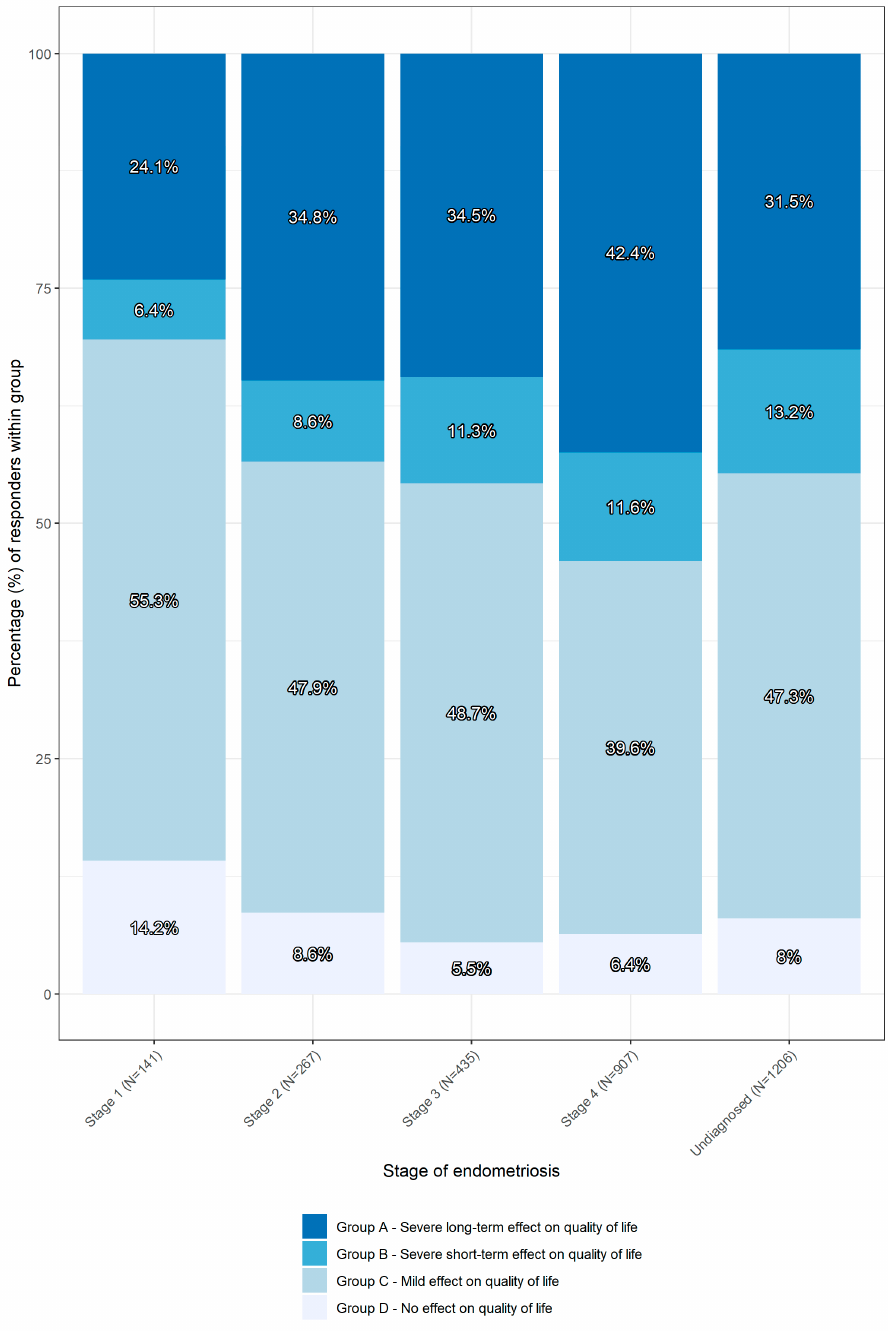
Figure 1. Reported everyday experiences of quality of life in relation to the stage. The figure shows the percentage of participants within a defined group related to the reported changes in quality of life. The percentages of participants are shaded. Group A is represented by the darkest shade, while group D is represented by the brightest shade.